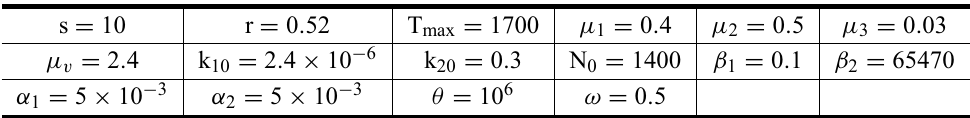
Model parameters used in the numerical simulations (Patient